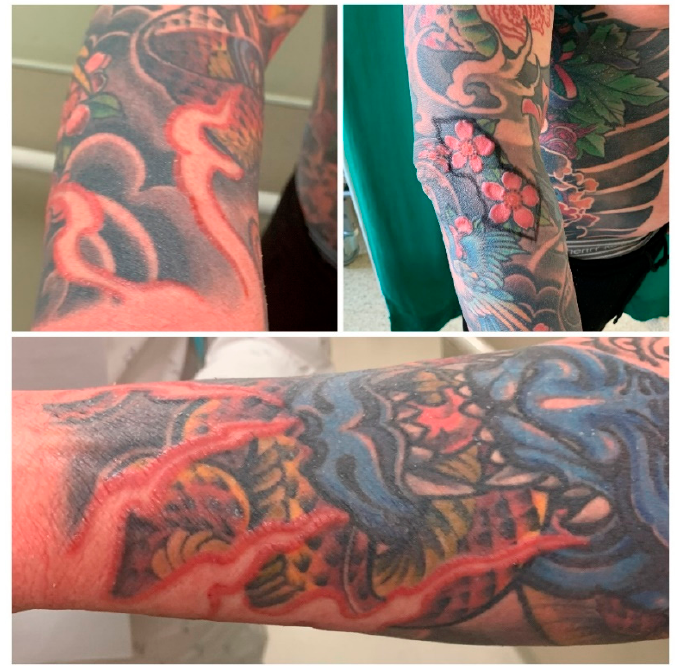
Figure 2. Skin changes (edema and granulomas demarcated by red floral- and flame-shaped tattoos) on red parts of tattoos on patient’s right forearm.